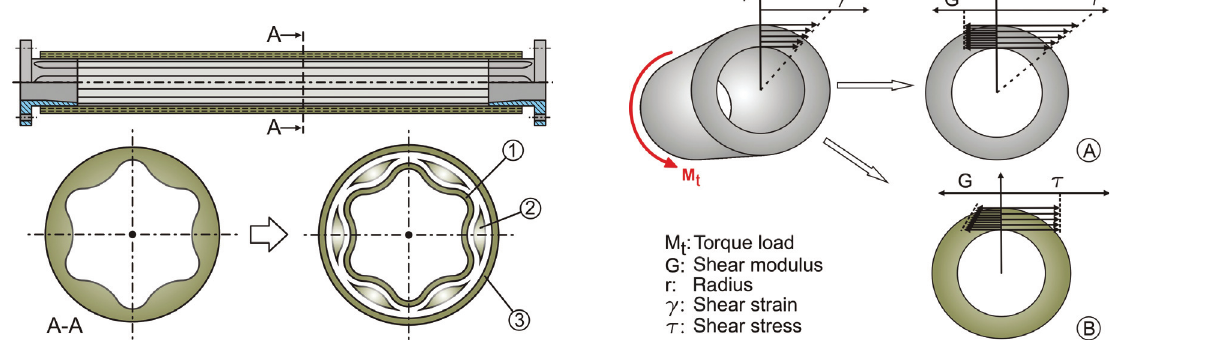
Figure 4 Stress distribution in shafts under torque loading for constant material stiffness properties (A) and for a designed aniso- tropic material